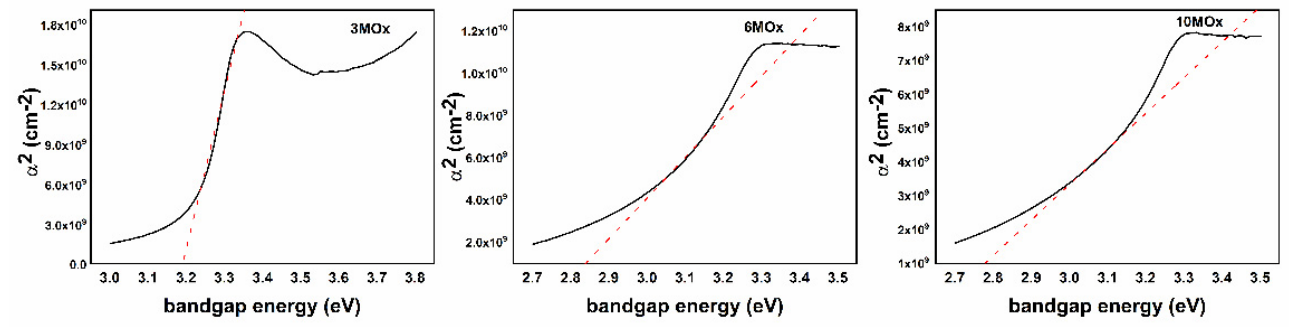
Figure A2. Tauc plots of samples 3MOx, 6MOx, and 10MOx,